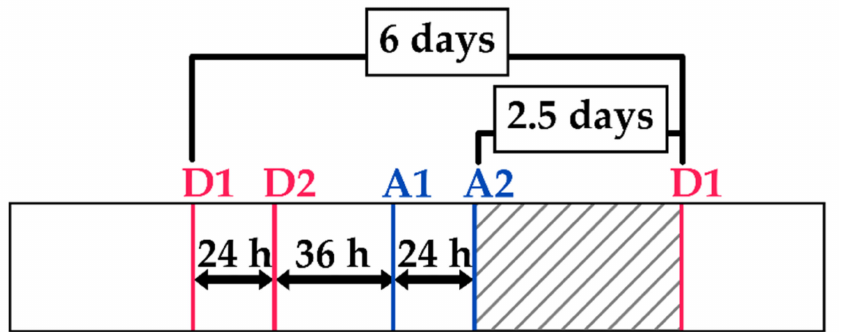
Figure 2. Example of the frequency of S1 images in ascending ‘A’ (evening, blue) and descending ‘D’ (morning, red) modes for the year 2020. Hatched area represents the period with no available SAR